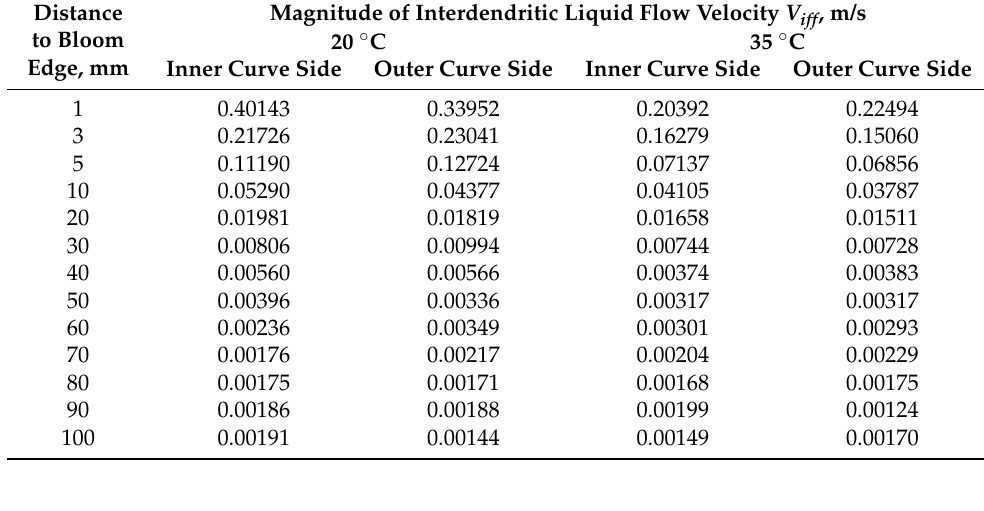
Table 6. Magnitude of interdendritic liquid flow velocity V if f in inner and outer curve sides under